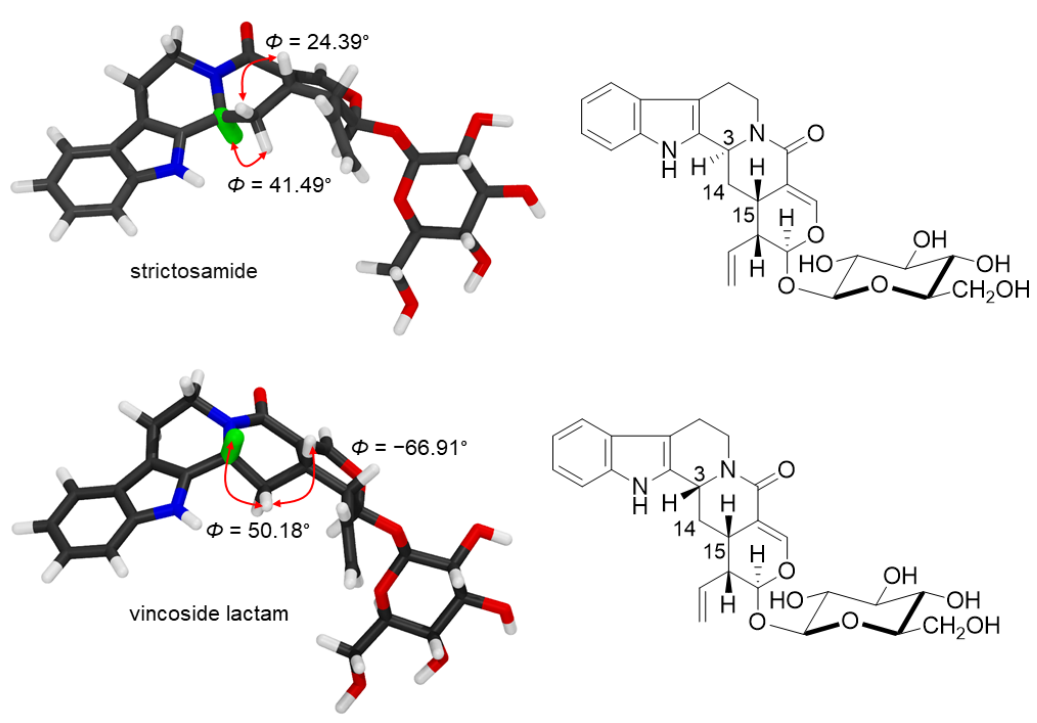
Figure 3. Comparison of the calculated 3D structures of strictosamide ( 1 ) and its C-3 enantiomer vincoside lactam.